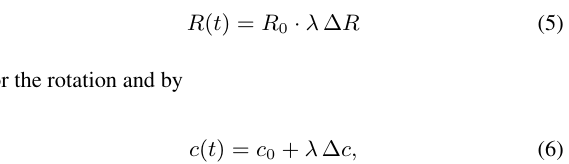
Table 2: Accuracy of the ground control and validations points used in our experiments. Points g3, v2, v3 are on a building roof (see Fig. 7 for a map). All other points have increased accuracy due to an additional tachimetric